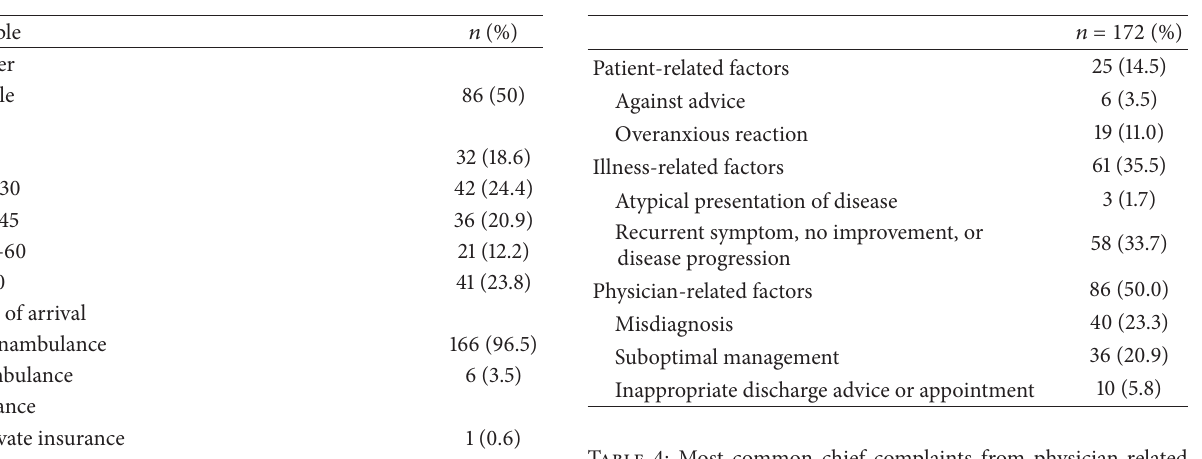
Table 3: The contributing factors for revisits.